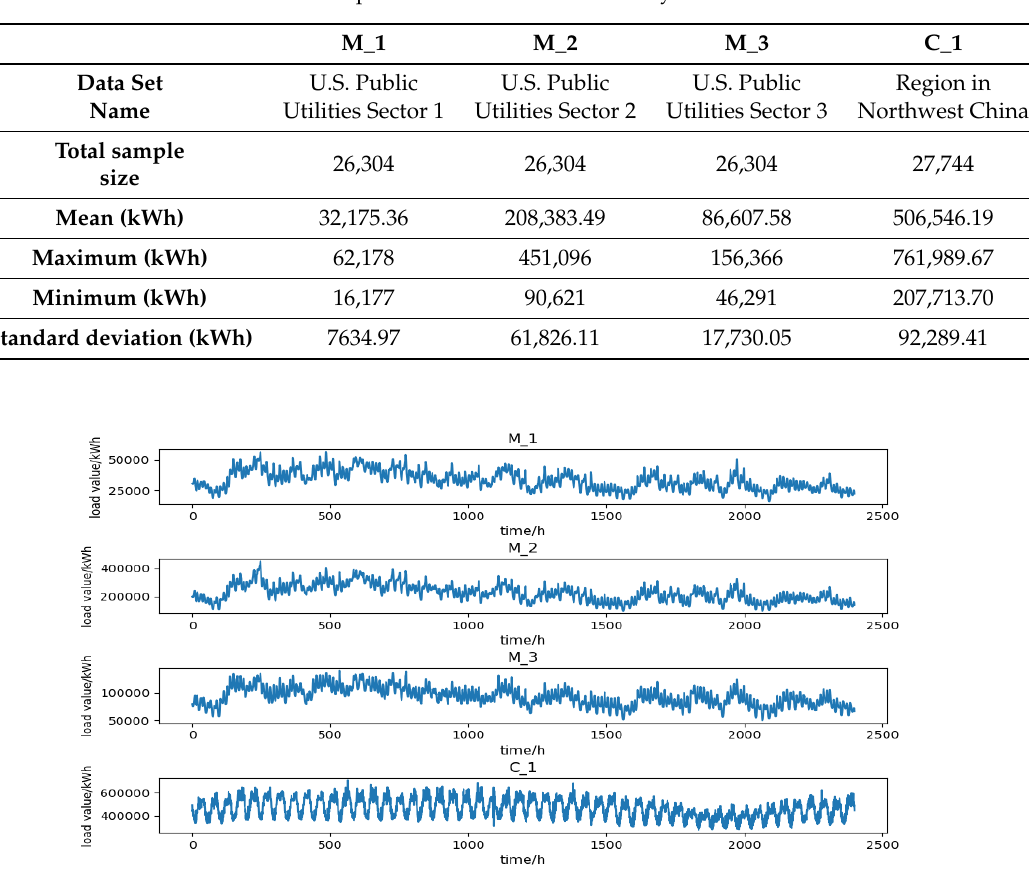
Table 1. Descriptive statistics of four electricity load datasets.